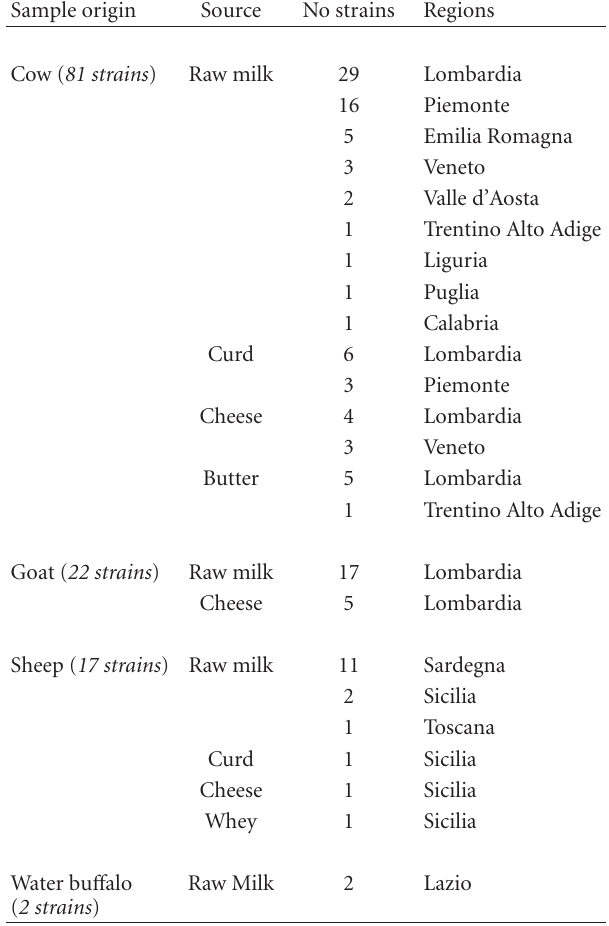
Table 1: Origin of the 122 S. aureus strains examined in this